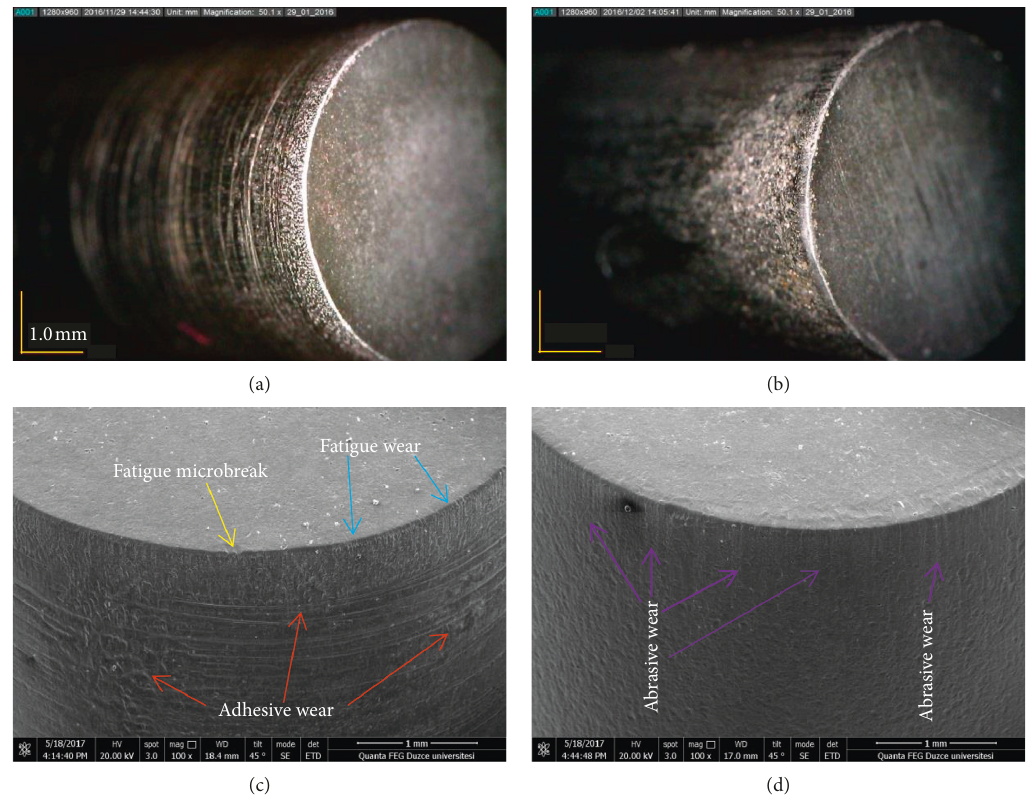
Figure 12: Edge and face wear of the circular punch at the 26.500 strokes (circular punch Ø6.2 × 100mm in diameter). (a) HT (OM × 50). (b) CT (OM × 50). (c) HT (SEM × 100). (d) CT (SEM ×